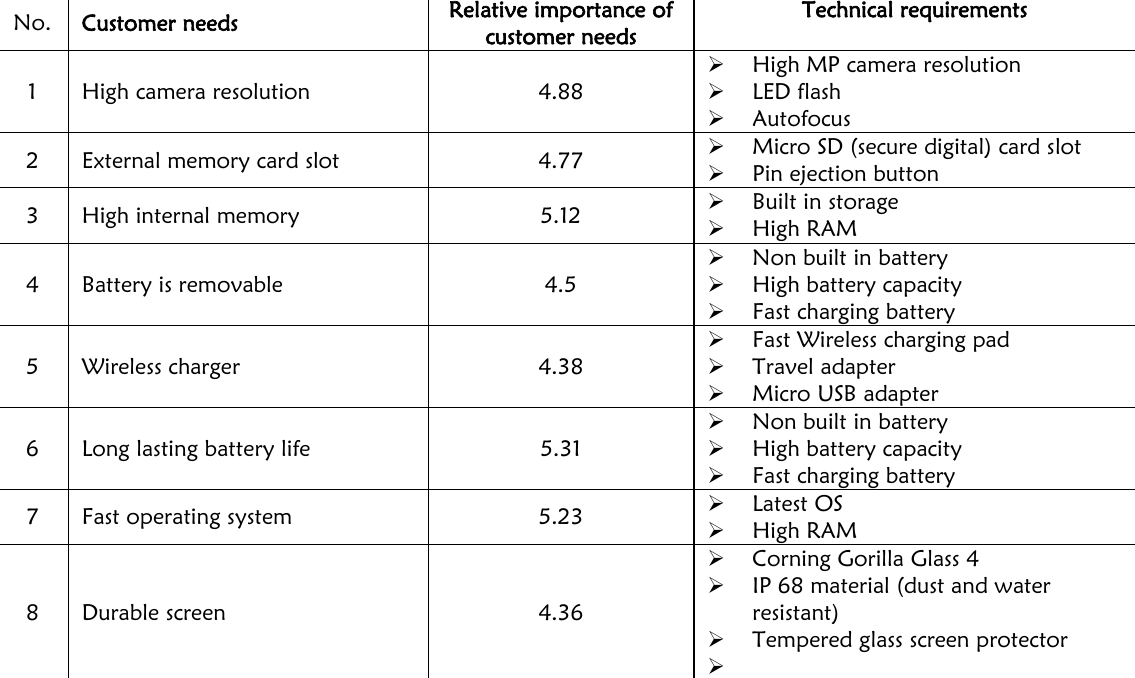
Table 2: Customer needs (their relative importance) and technical